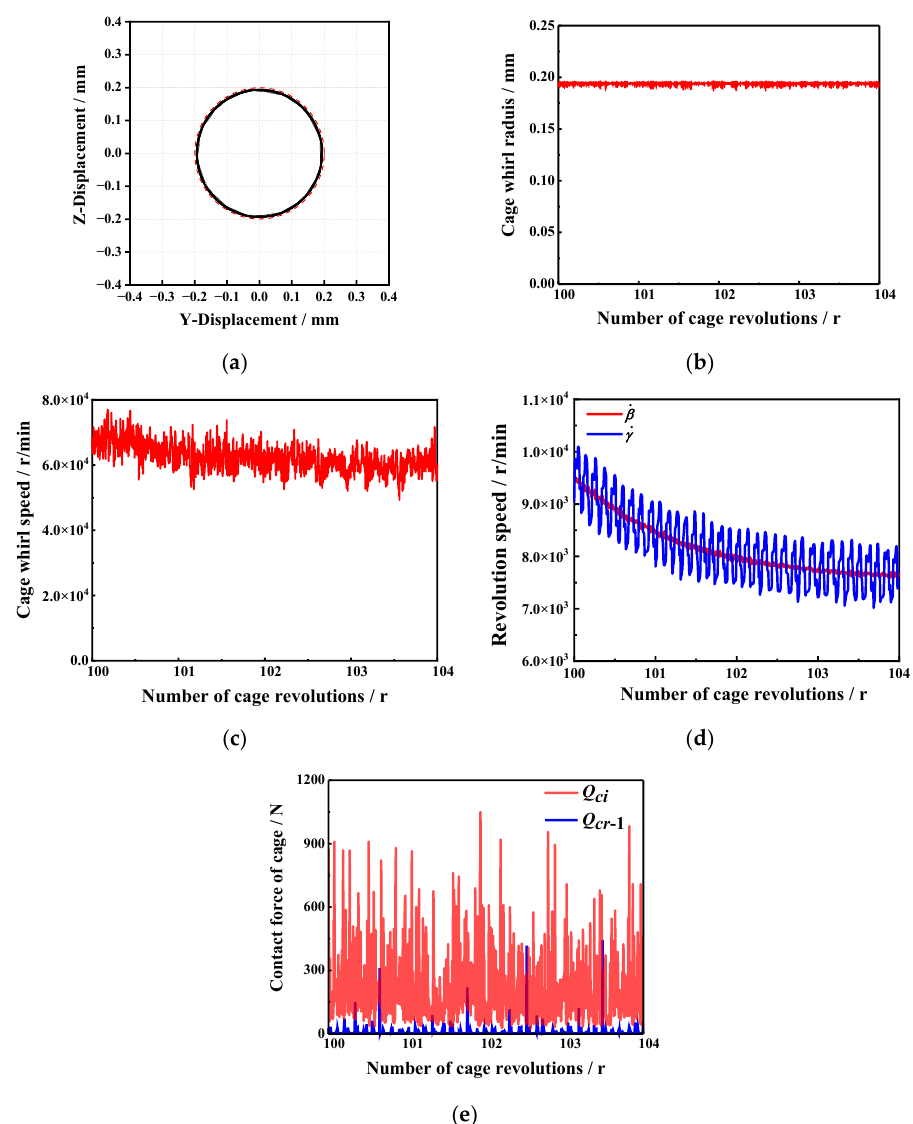
Figure 10. Whirl parameters and force of the cage under operating condition 4: ( a ) whirl orbit; ( b ) whirl radius; ( c ) whirl speed; ( d ) rotational speed of rollers and cage; ( e ) force on